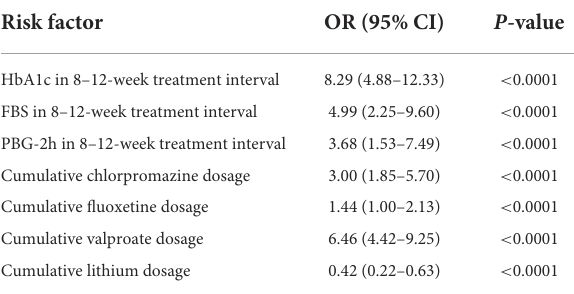
TABLE 4C Multivariate analysis of risk factors for cognitive impairment in patients with MDD.